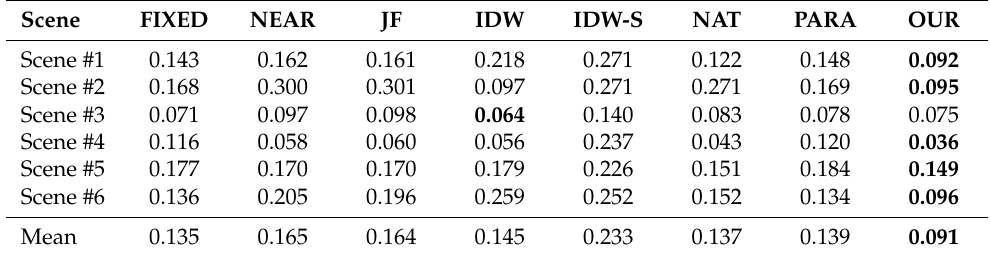
Table A1. LPIPS scores of the presented approaches compared with our own approach. Lower score means higher similarity. The best results are highlighted in bold.